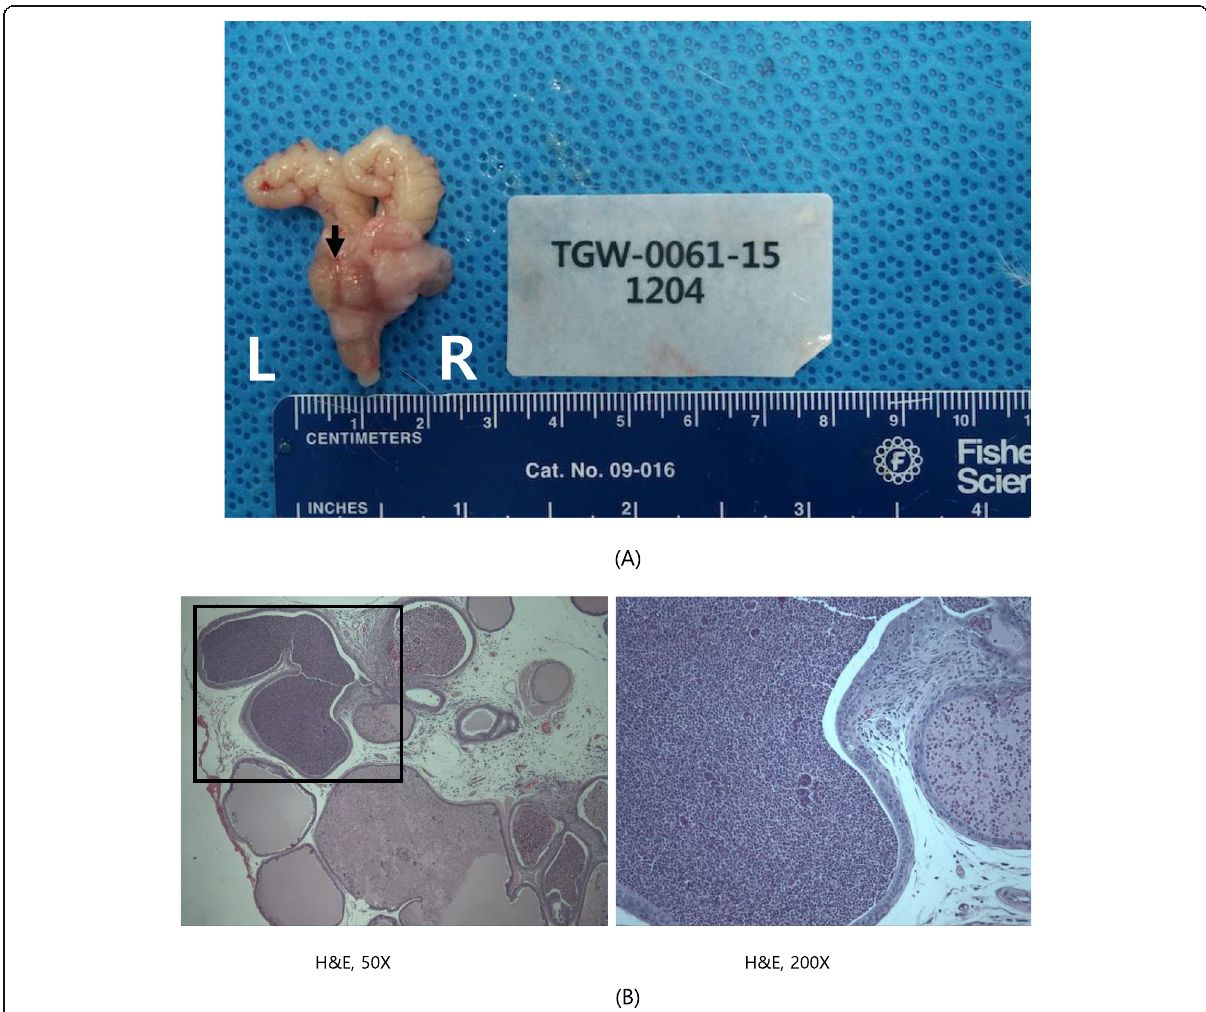
Fig. 5 Yellowish nodules on the prostate gland of male G2 (low dose group; rat number 1204) ( a ) Necropsy finding, ( b ) Abscess; H&E 50X,